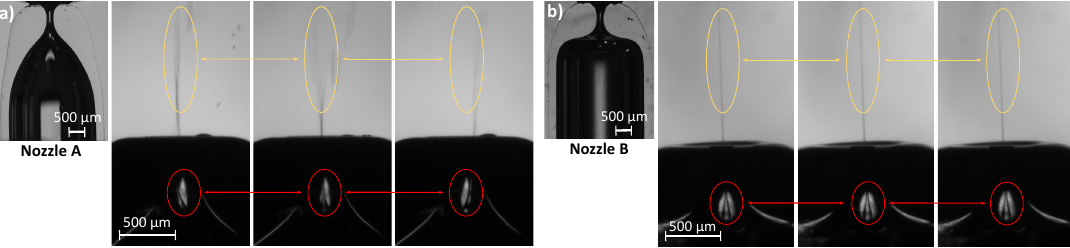
Figure 12. Sequences of experimental images of the jet emitted by the two GDVNs devices with ( a ) Nozzle A and ( b ) Nozzle B. The water inner flow rate is Q = 6.9 mL/h and the air pressure drop is ∆ p = 300